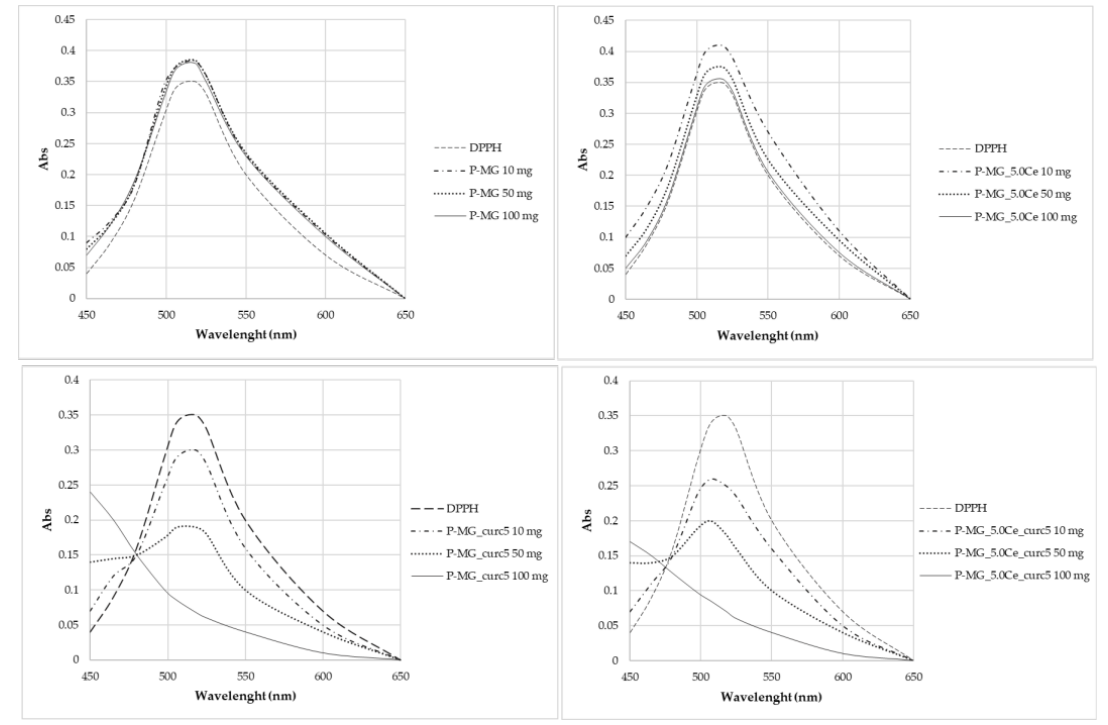
Figure 12. UV-Vis absorption spectra after 2 h contact with DPPH. Curcumin expresses activity as a radical scavenger [2]. For this region, this work also investigated the concentration at which curcumin does not cause the complete degrada- tion of DPPH (Figure 13). Different concentrations were studied: 5·10 – 3 mg/L, 3.3·10 – 3 mg/L, and 1.7·10 – 3 mg/L. None of these solutions brought about the complete degradation of DPPH in 2 h time.